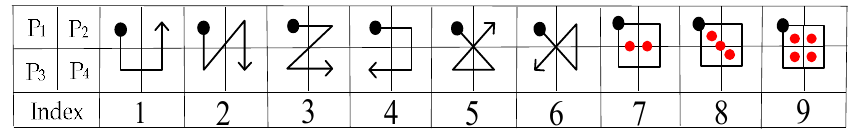
Figure 3. Nine types of motif patterns.